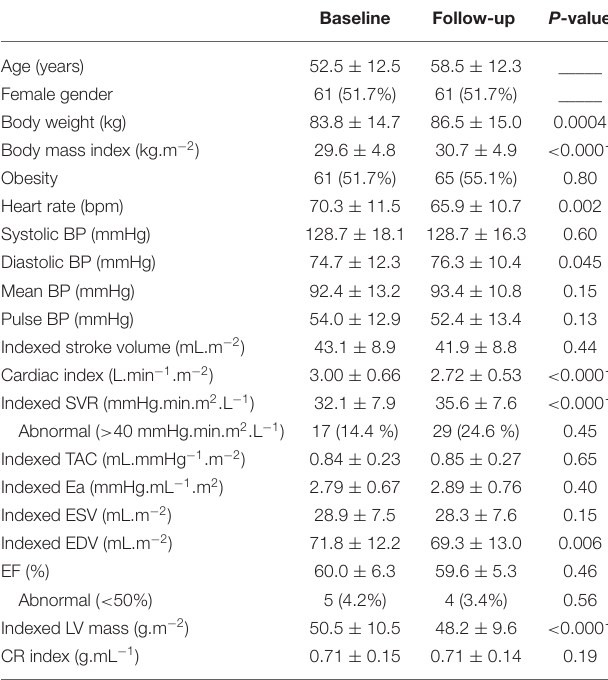
TABLE 2 | Association between longitudinal changes in LVEF and baseline and TABLE 1 | Comparison of the main recorded data between baseline and concomitant changes in clinical and hemodynamic variables. follow-up. Baseline